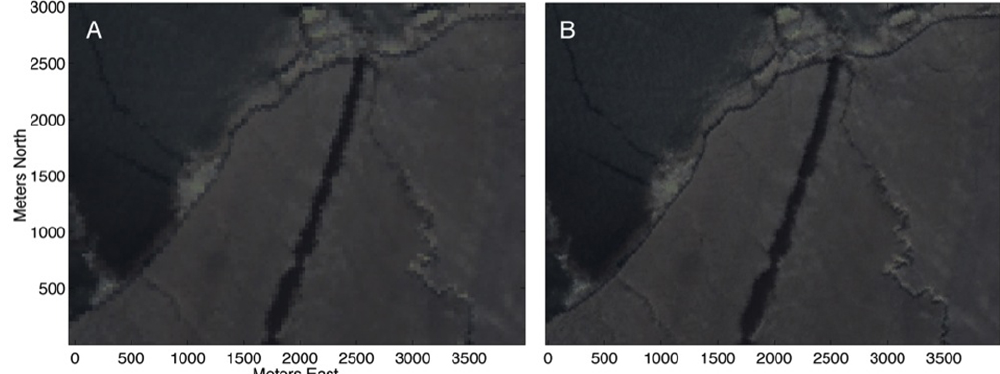
Figure 2. Example subset of a natural color (bands 1, 2 and 3) Landsat-7 ETM + image at (a) original 30m resolution and (b) after pan- sharpening to 15m using band-8. This example highlights the improvement in resolution of common ice sheet features including a glacier calving front, medial moraine and supraglacial melt water stream